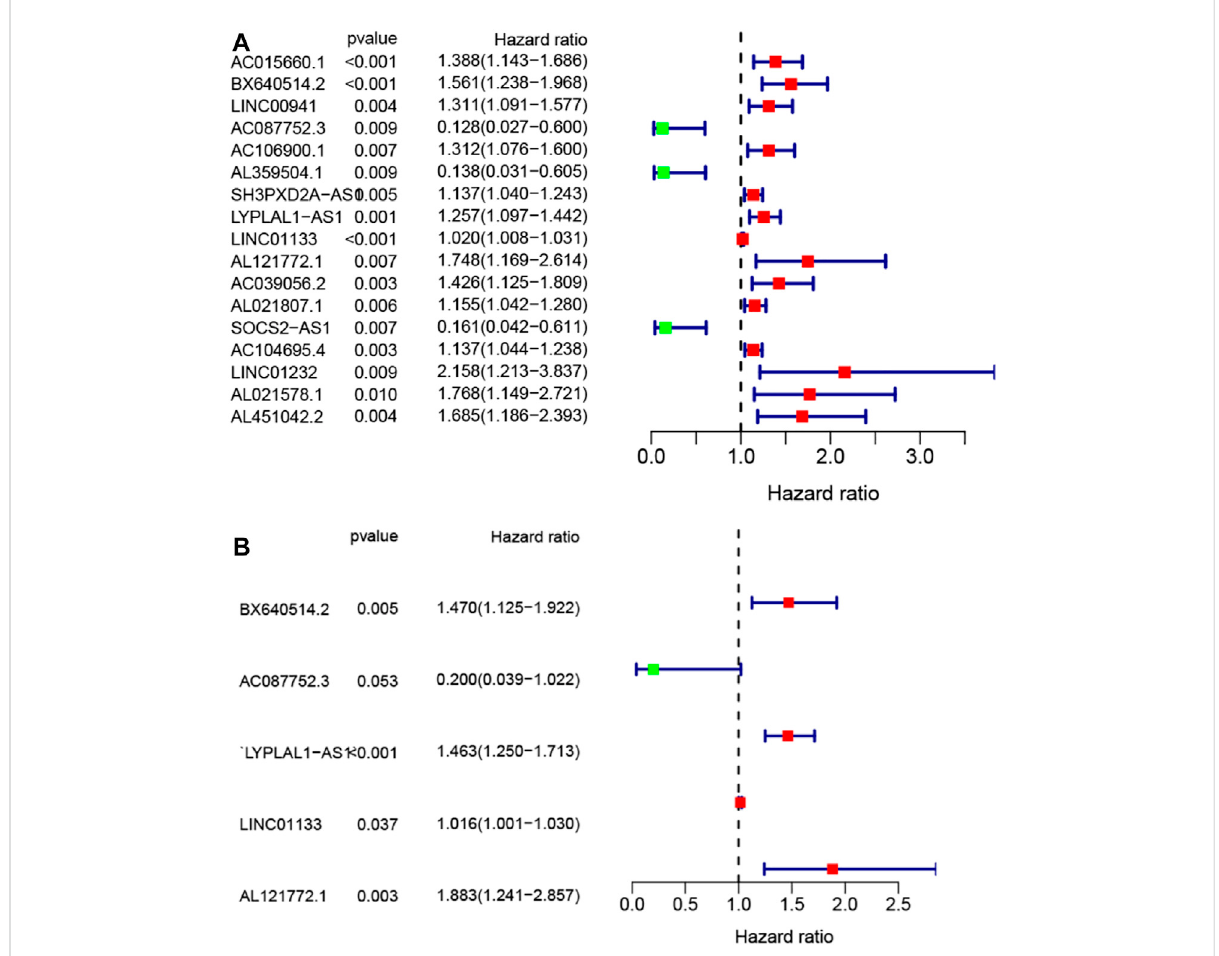
FIGURE 4 Constructionofthegenomicinstability-associatedlncRNAprognosticsignaturefromthetrainingset. (A) Forestplotof17candidateprognostic LncRNAs associated with pancreatic cancer patients ’ overall survival based on univariate Cox regression analyses. (B) Forest plot of fi ve candidate prognostic LncRNAs associated with pancreatic cancer patients ’ overall survival based on stepwise multivariate Cox proportional hazard